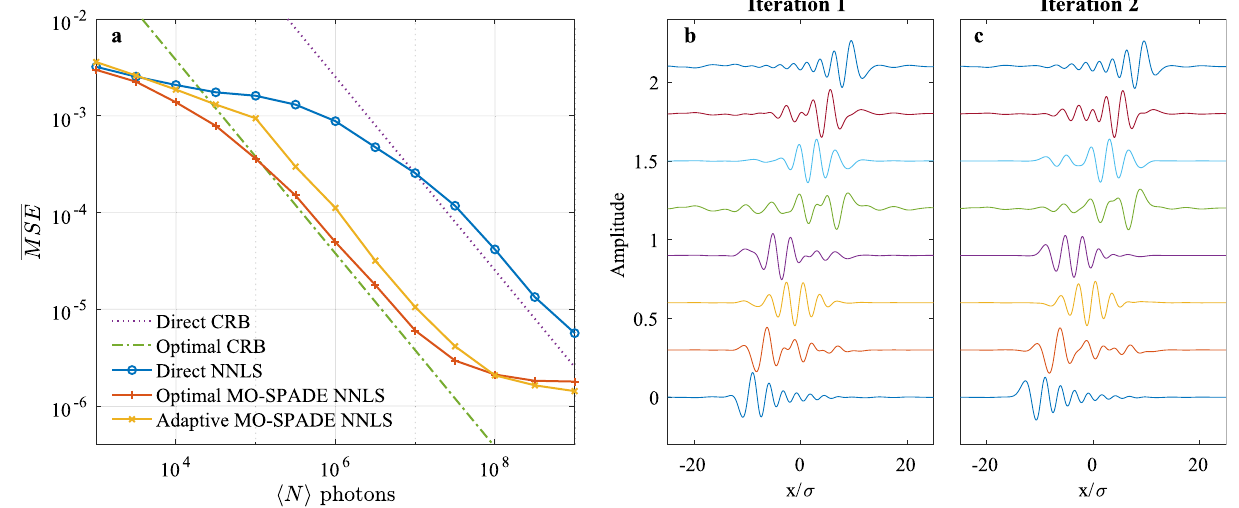
Figure 4. Adaptive imaging simulations. ( a ) Monte Carlo simulations of adaptive imaging for the source in Fig. 3b discretized into widths of a = 0.8 σ . Each data point represents the MSE of 25 trials averaged over all source coefficients. Optimal MO-SPADE refers to the case where prior knowledge of the source is used in optimizing the modes, while adaptive MO-SPADE follows the adaptive imaging procedure outlined in the main text, with no prior knowledge of the source assumed. Only 8 imaging modes are used in the adaptive imaging. Note that at low photon levels, the bias of the NNLS estimator allows the MSE to go below the CRB, while at high photon levels, the MSE of all methods approaches an error floor due to the discretized approximation of the continuous source. ( b , c ) The imaging modes for the two iterations of the adaptive imaging process for a 6 specific Monte Carlo trial with � N � = 10